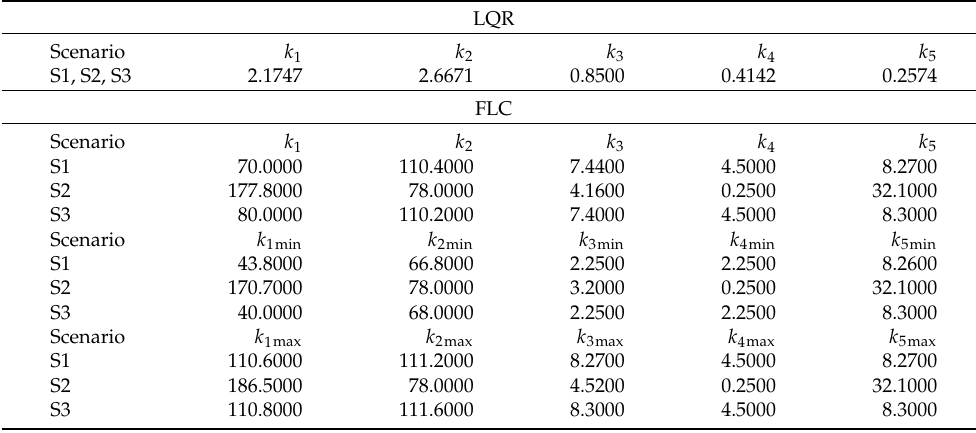
Table 3. Controller gains, Area 1.